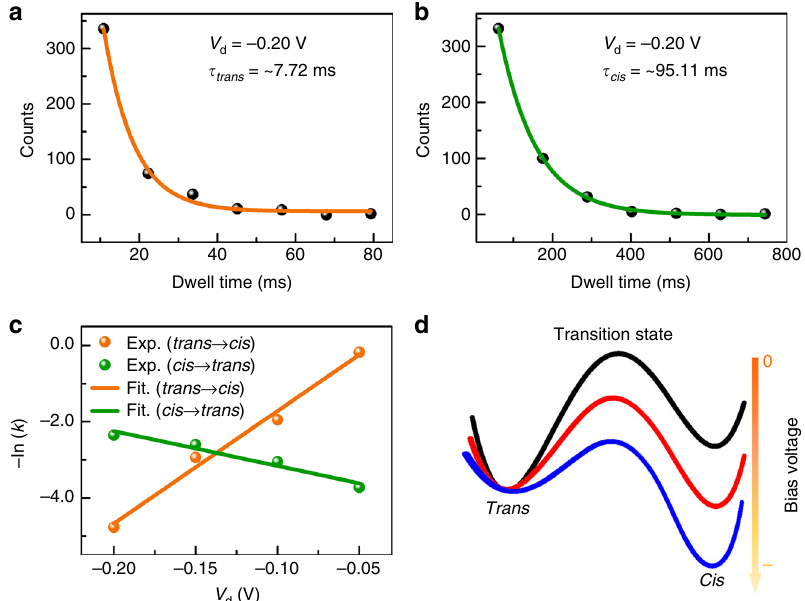
Fig. 6 Relationship between the activation energy and the bias voltage. a , b Statistics histograms of the dwell times at trans ( a ) and cis ( b ) states fi tted by a single-exponential function. c Activation energy parameters of trans – cis (orange) and cis – trans (green) as a function of the bias voltage. The variation of cis – trans is less than trans – cis . d Schematic of the energy alignment among trans , cis , and transition states triggered by the bias voltage. We take the energy of trans as the